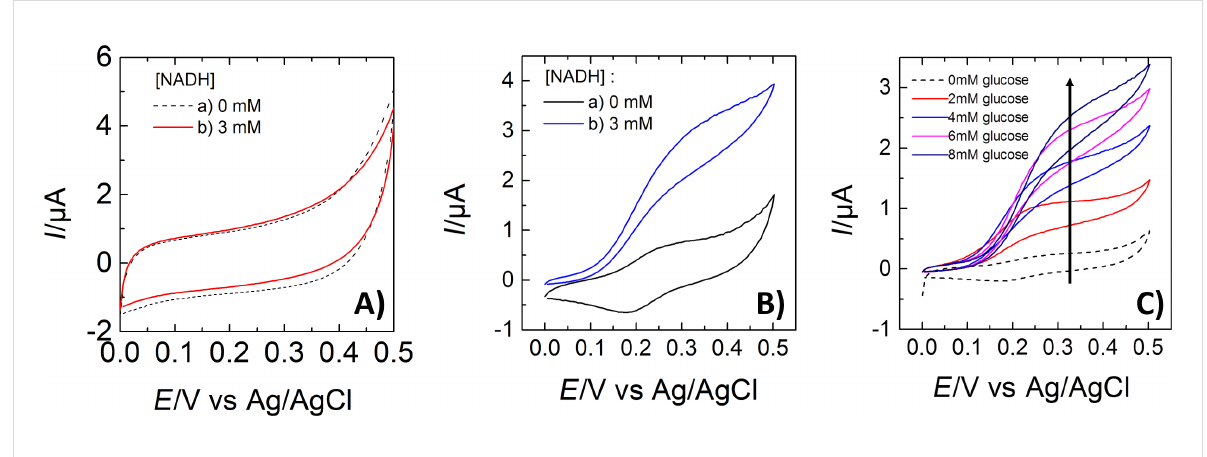
Figure 11: Cyclic voltammograms obtained of GCEs modified with A) HIPCO-H 2 SO 4 immobilized with diaphorase; B) HIPCO-H 2 SO 4 -FcETG 2 immo- bilized with diaphorase; C) HIPCO-H 2 SO 4 -FcETG 2 immobilized with diaphorase, NADH and glucose dehydrogenase (GDH) molecules. In A and B, NADH was added to the analyzed solution; in C, glucose was added to the solution. The modified GCE electrodes were used as working electrodes in a conventional three-electrode setup. The scan rate was 5 mV·s − 1 . Arrows in B indicate the anodic and cathodic wave of the grafted ferrocene